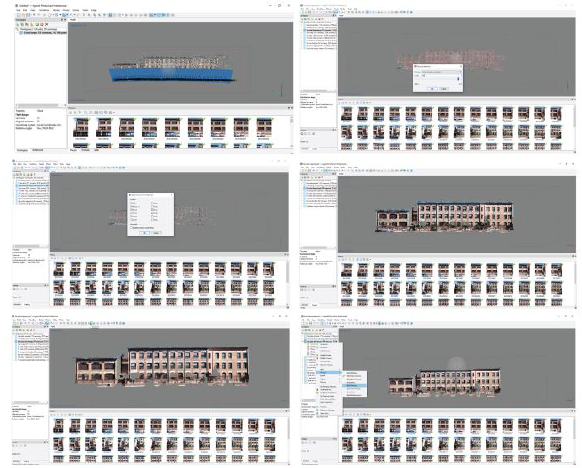
Figure 13. Terrestrial photomodelling on the side facade of the G. Pascoli